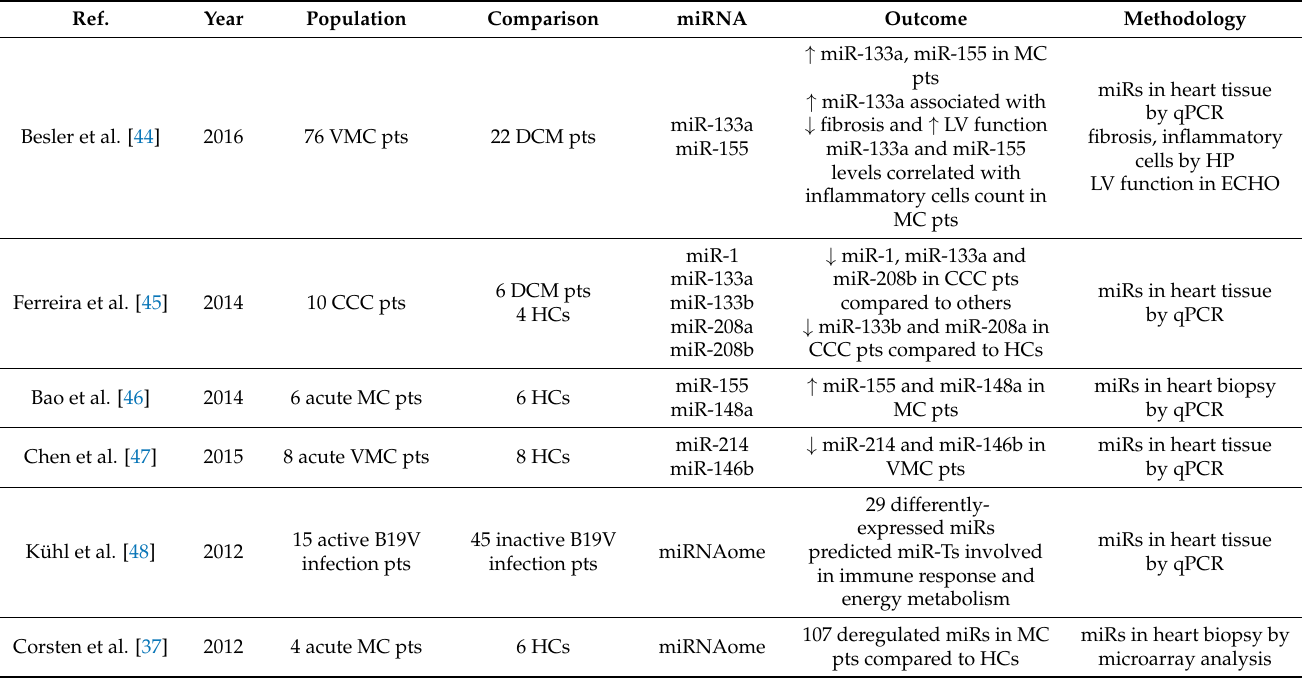
Table 2. Summary of recent studies regarding tissue microRNAs in adult myocarditis